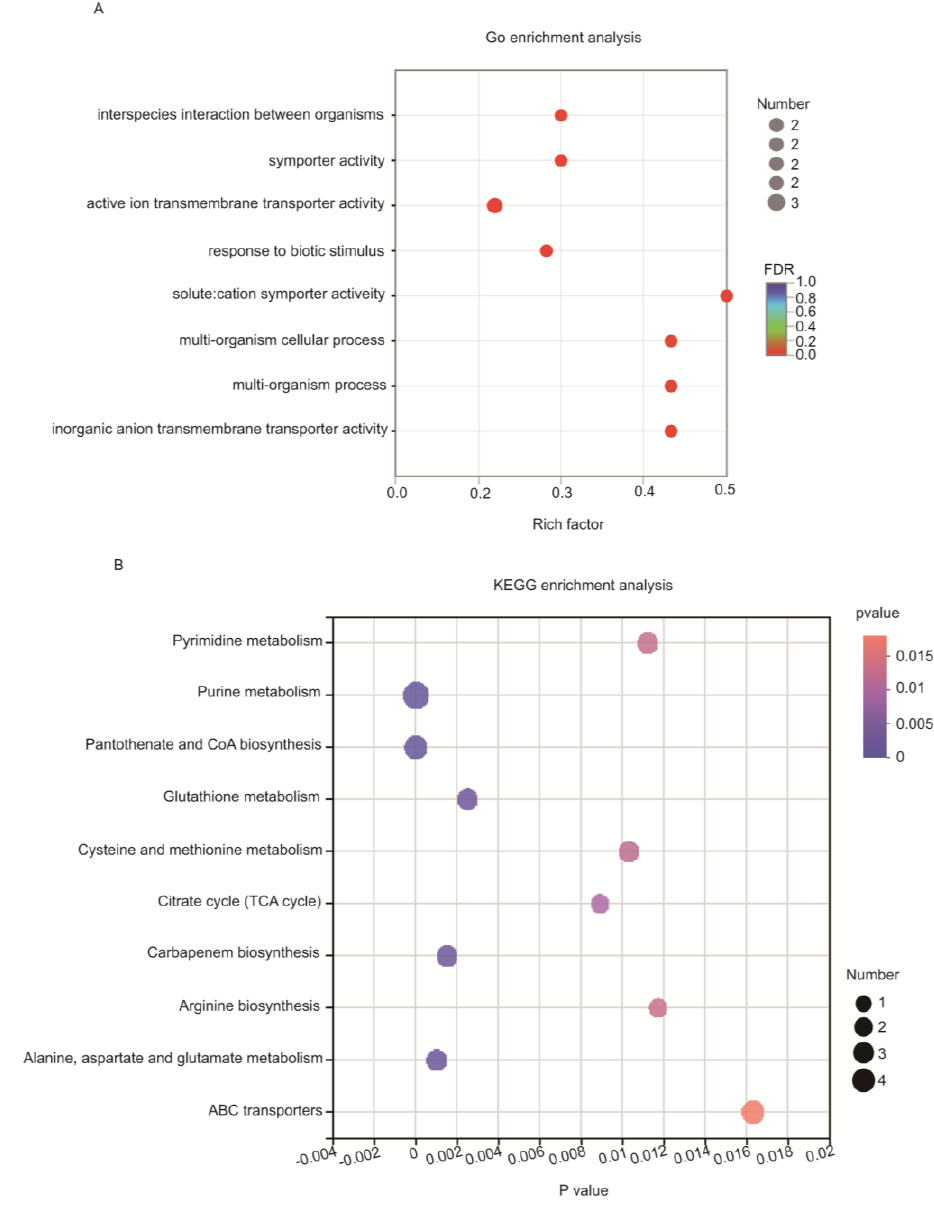
Figure 5. Functional characterization of the DEGs and differential metabolites. The statistical enrichment of differential expression genes in Go pathways ( A ). The x -axis shows the rich factor of each GO pathway. The greater the rich factor, the greater the degree of enrichment. The size of the dots indicates the number of genes involved in each GO pathway. The colors of the dots indicate the p -value; the statistical enrichment of differential expression metabolisms in KEGG pathways ( B ). The sizes of the dot indicate the number of metabolisms involved in each KEGG